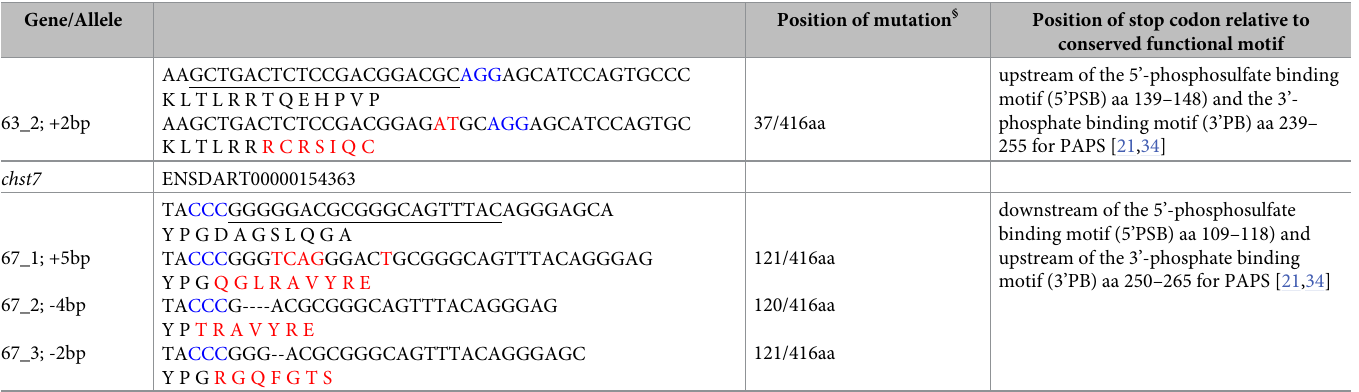
shortened and stouter in the adult csgalnact1a mutant (Fig 2H, arrow) compared to control adults (Fig 2G), resulting in a constantly open mouth (Fig 2J, arrow). Other morphological fea- tures of the csgalnact1a mutants were the protruding eyes and the widened angle of the cera- tohyal element in mutants (Fig 2L). As a comparison, Csgalnact1 -/- mice showed impaired intramembranous ossification of the skull resulting in a shorter face, higher and broader cal- varia, reminiscent of the zebrafish csgalnact1a -/- phenotype [24]. In contrast to the zebrafish phenotype, the lower jaw in mice were largely unaffected. Human patients with mutations in CSGALNACT1 have been described in several studies with mild skeletal dysplasia [35–37]. Our zebrafish csgalnact1a -/- line may thus serve as a model to study this rare human syndrome (OMIM 618870).